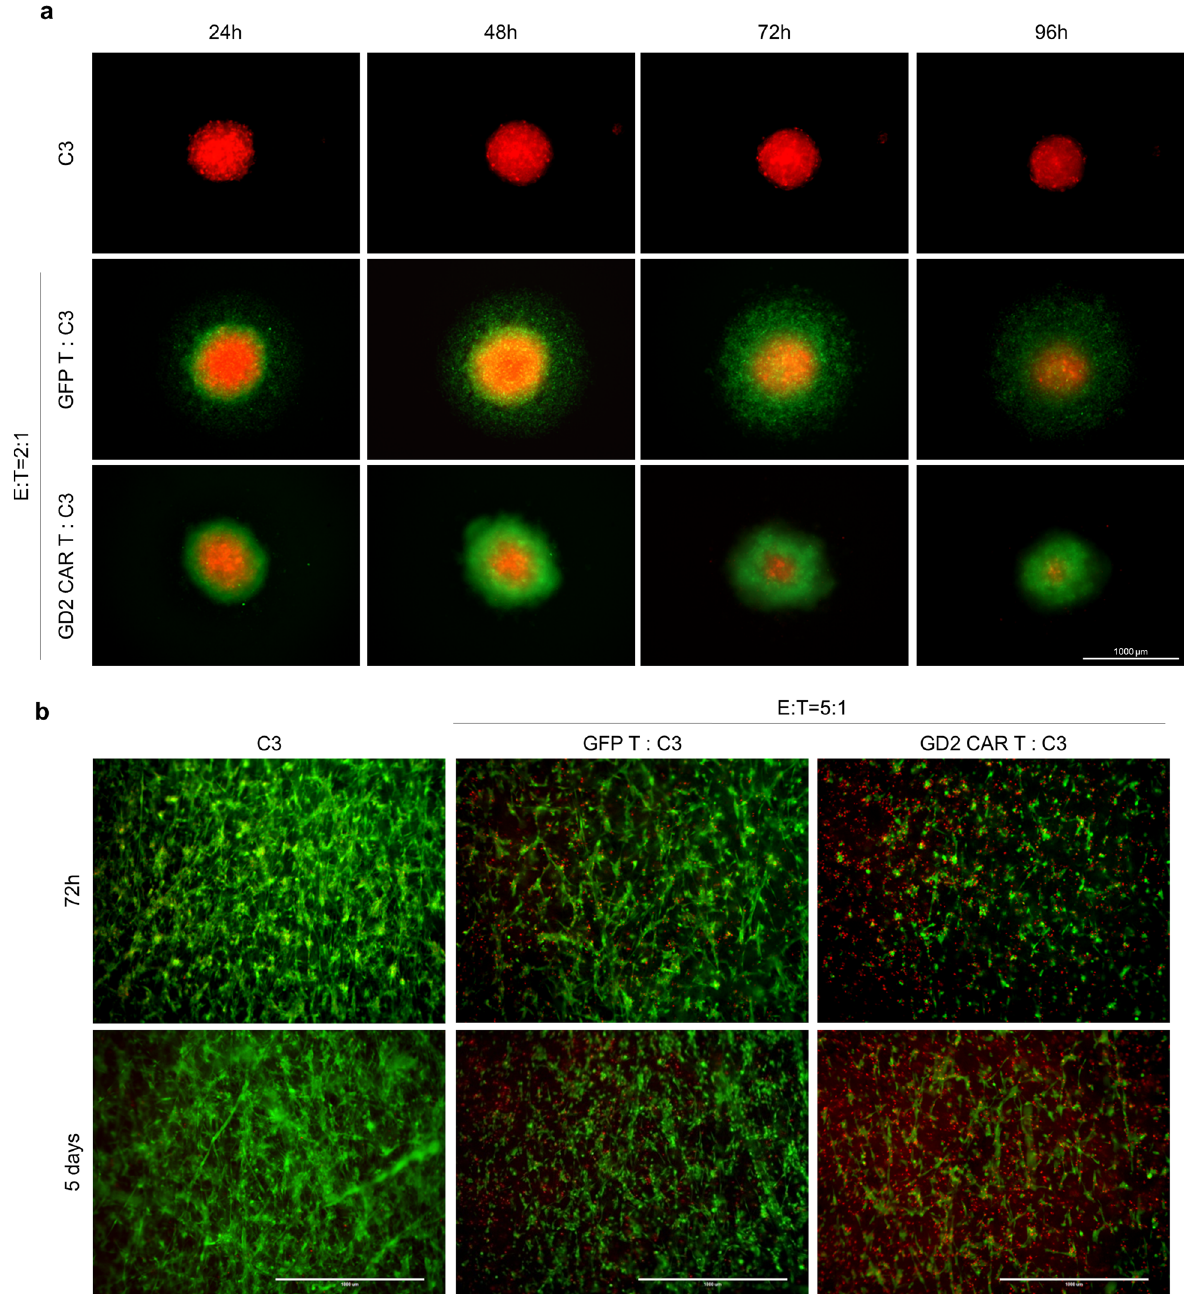
Fig. 6 Three-dimensional in vitro models con fi rm GD2 CAR T speci fi c action against glioblastoma. a Representative fl uorescence microscopy images of glioblastoma spheroids alone (upper row) or in co-culture with either GD2 CAR T (bottom row) or GFP control T cells (middle row) at 2:1 E:T ratio. CAR T cells antitumor activity is monitored at 24, 48, 72, and 96 h. Tumor cells in red, GD2 CAR T cells and GFP control T cells in green. The scale bar is 1000 µm. b Representative fl uorescence microscopy images of primary C3 glioblastoma cells forming a tissue-like structure in VITVO ® 3D bioreactor at 72 h and 5 days (left row) and then in co-culture with GD2 CAR T (right row) and GFP control T cells (middle row) at 5:1 E:T ratio. A fl uorescence-based live/dead assay is used to monitor the cytotoxic effect of CAR T cells at 72 h and 5 days (living cells in green, dead cells in red). The scale bar: 1000